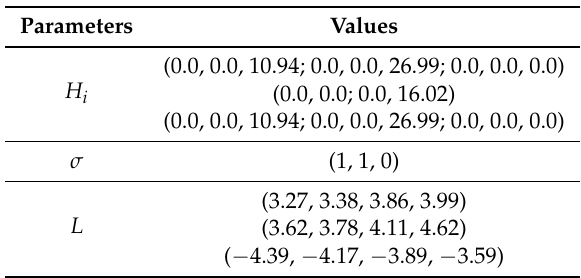
Table A3. Parameters obtained after training the AHN-model.